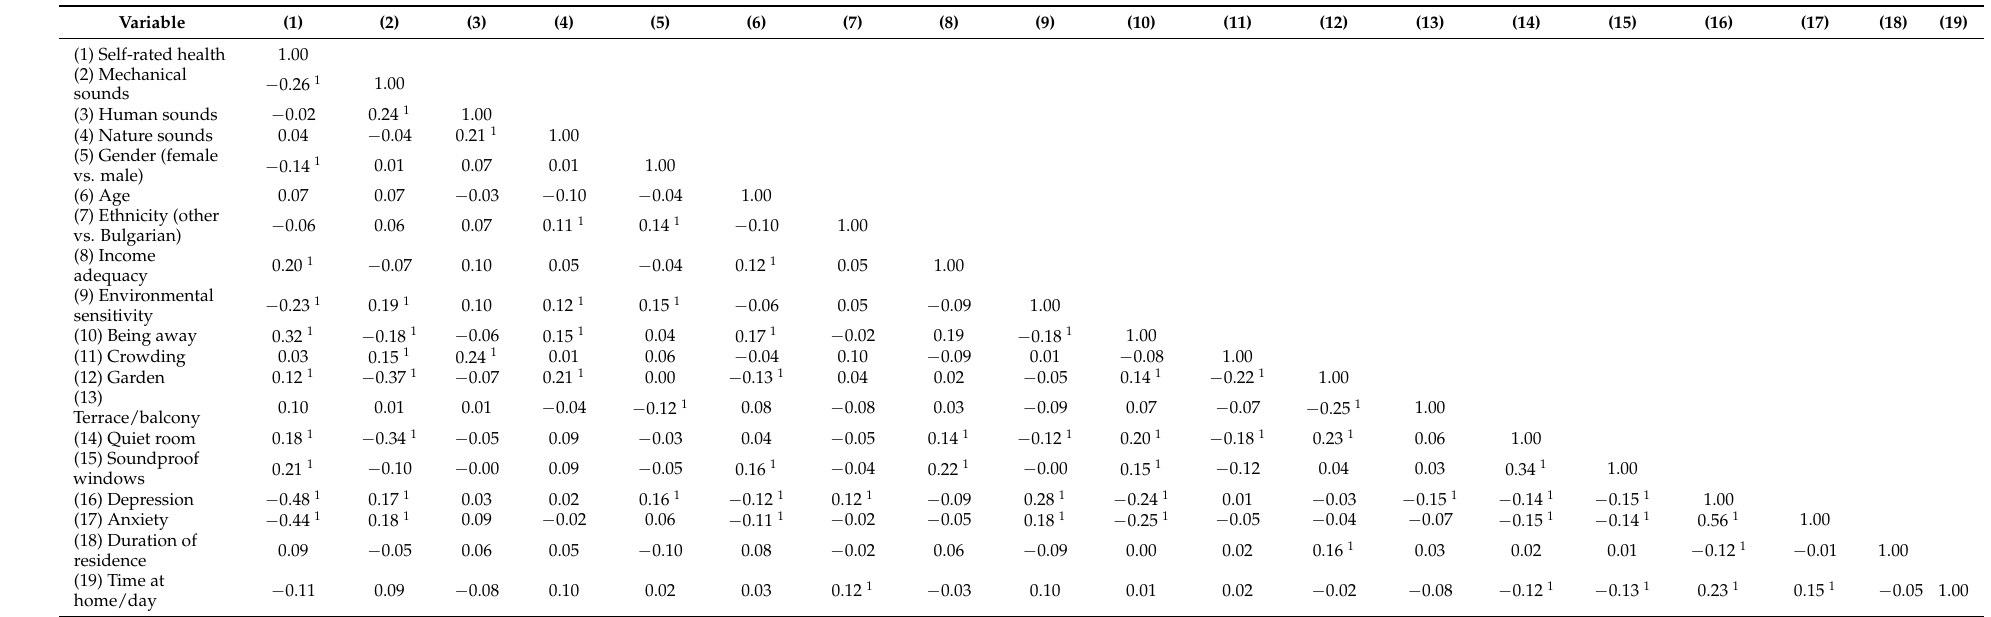
Table 3. Spearman correlations between the main variables in the